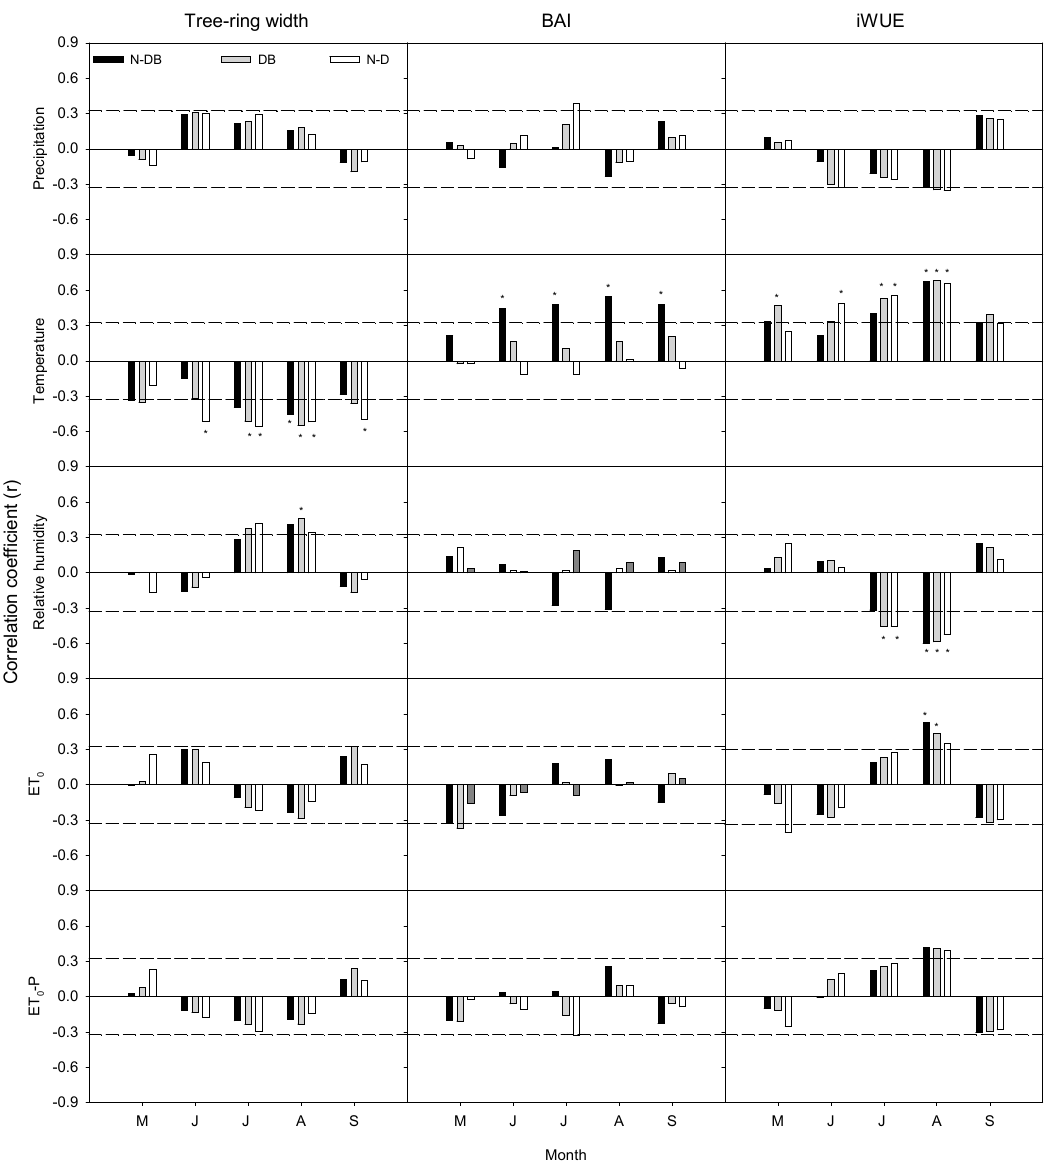
Figure 8. Relationships between tree-ring parameters (tree-ring width; BAI, iWUE) and monthly climatic factors for non-dieback (filled bar), dieback (grey bar), and now-dead (empty bar) tree groups in growth season (May–September). Months abbreviated in uppercase letters correspond to years during tree-ring formation. Dashed lines represent threshold values for statistical significance ( p < 0.05). Asterisks (*) indicate significant correlation at p < 0.01.